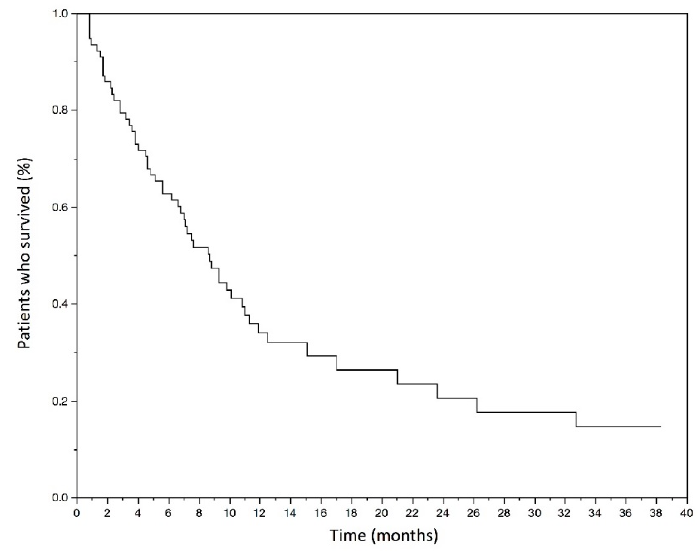
Figure 1. Kaplan–Meyer estimates of overall survival in months in the studied